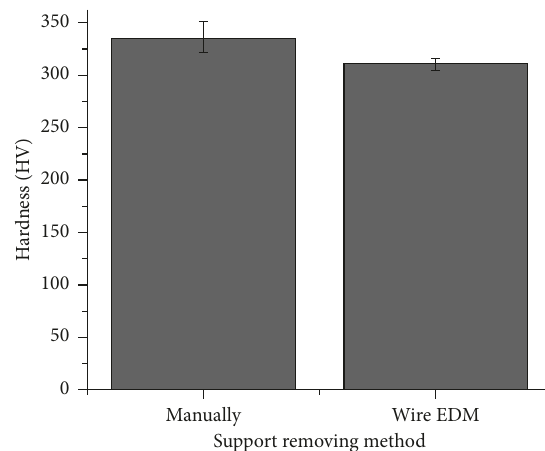
Figure 9: Effect of the support-removal method on